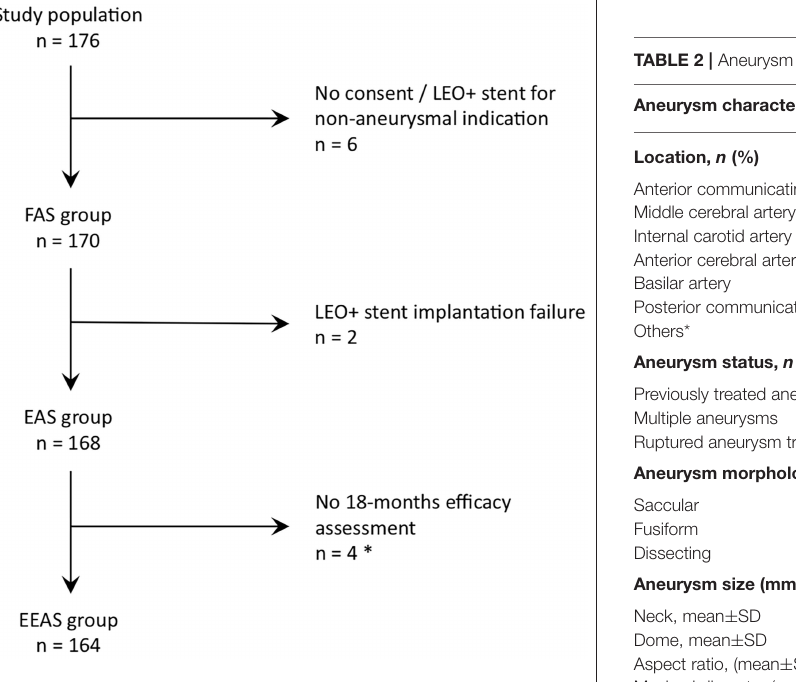
FIGURE 1 | FAS, Full analysis set; EAS, Evaluable analysis set; EEAS, Efficacy evaluable set. * Four early withdrawals for non-medical reasons, one lost to